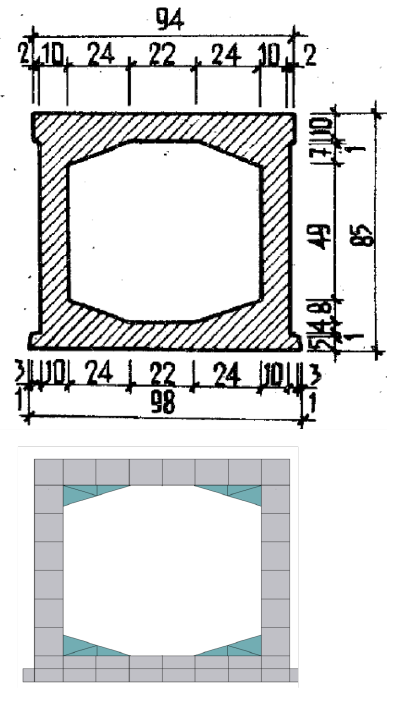
Figure 1. Cross-section of a singe bridge girder